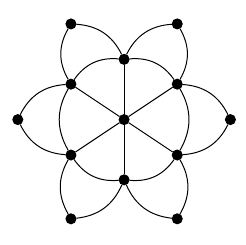
Figure 3. Flower graph Fl